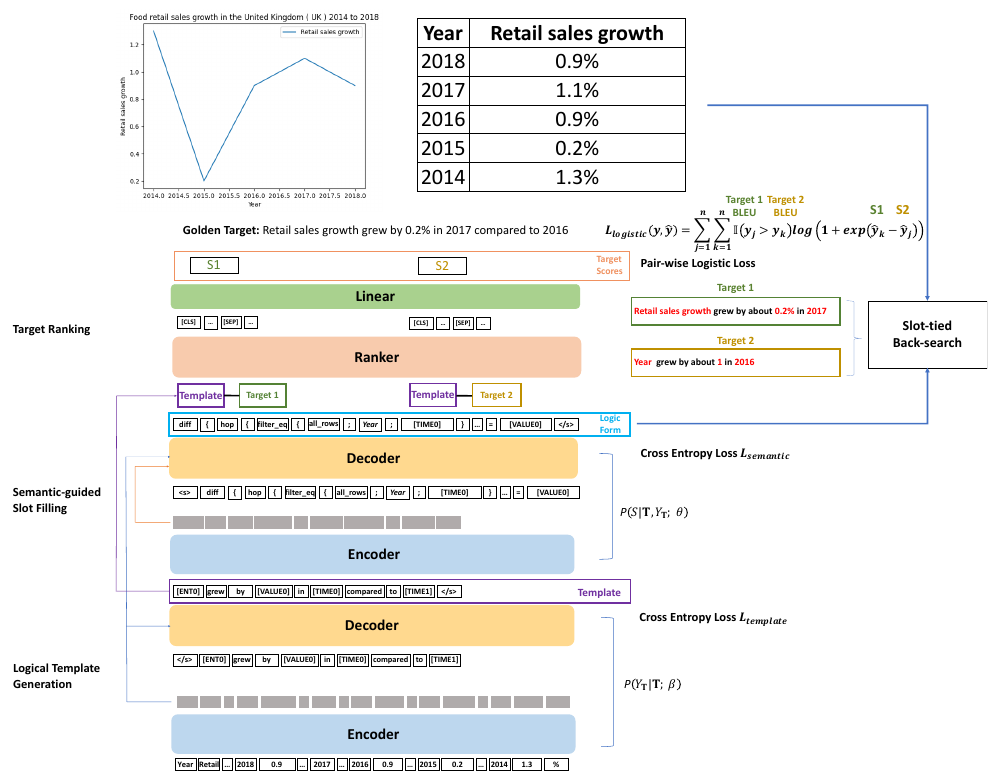
Figure 4. The SP-NLG framework structure.